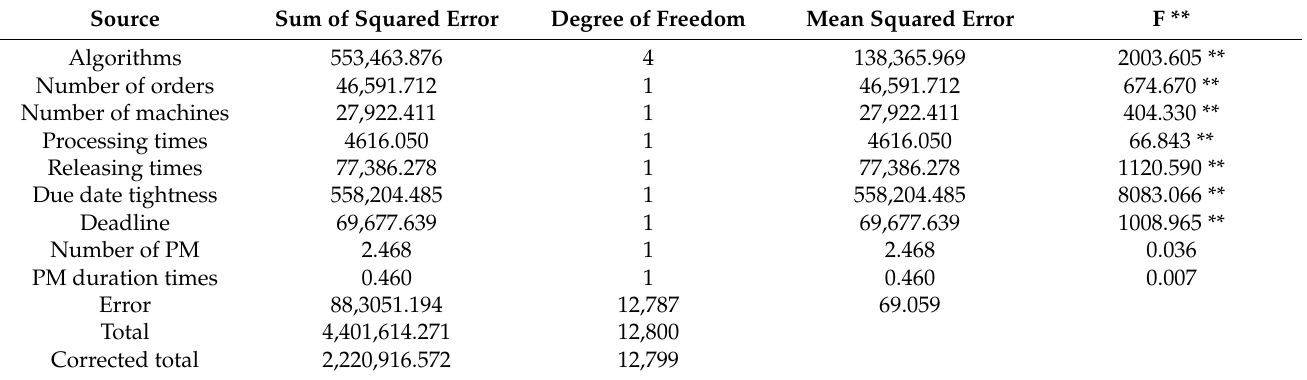
Table 2. ANOVA table for testing the significance of all algorithms and factors ( α =